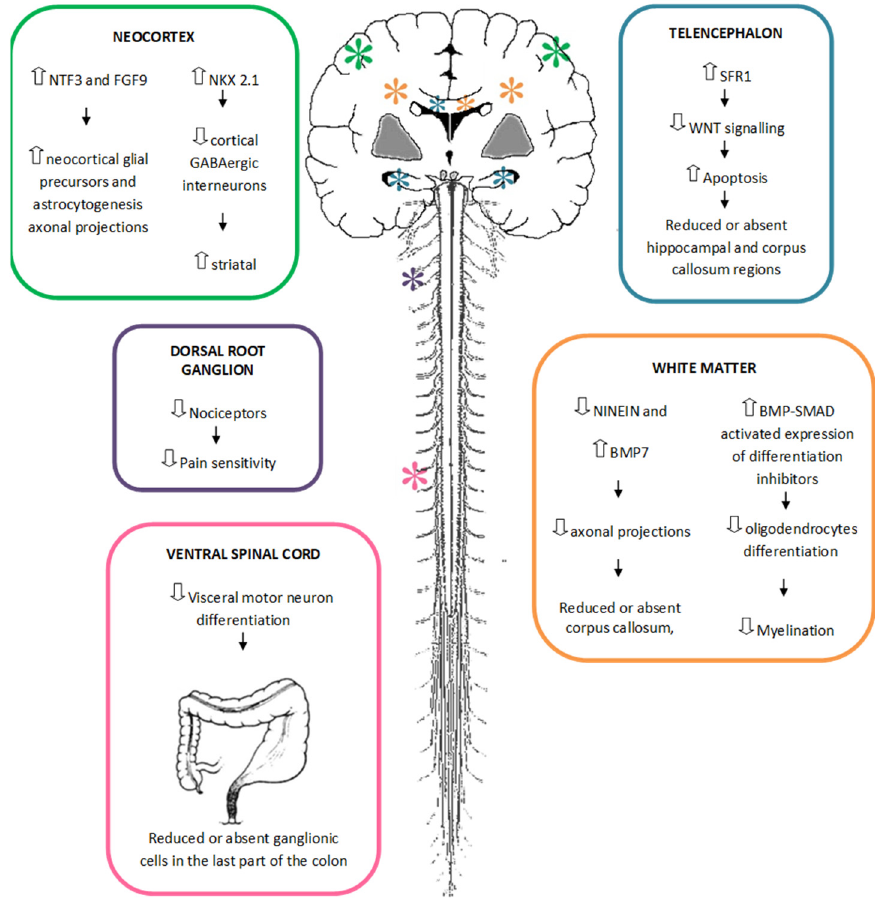
Figure 1. Role of ZEB2 haploinsufficiency in central and peripheral nervous system development